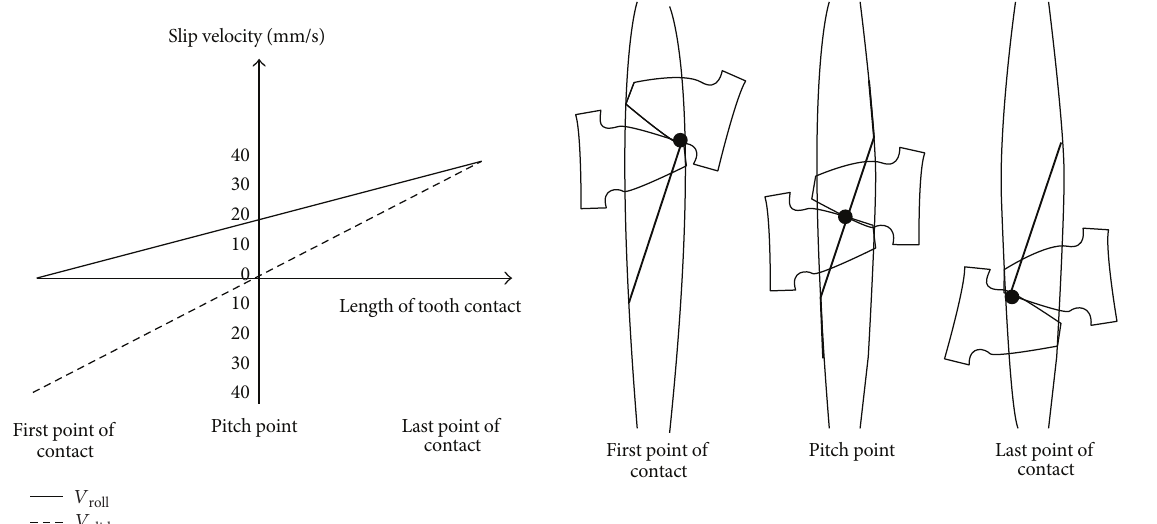
F 2: e line of contact and the rolling/sliding speeds along the contact